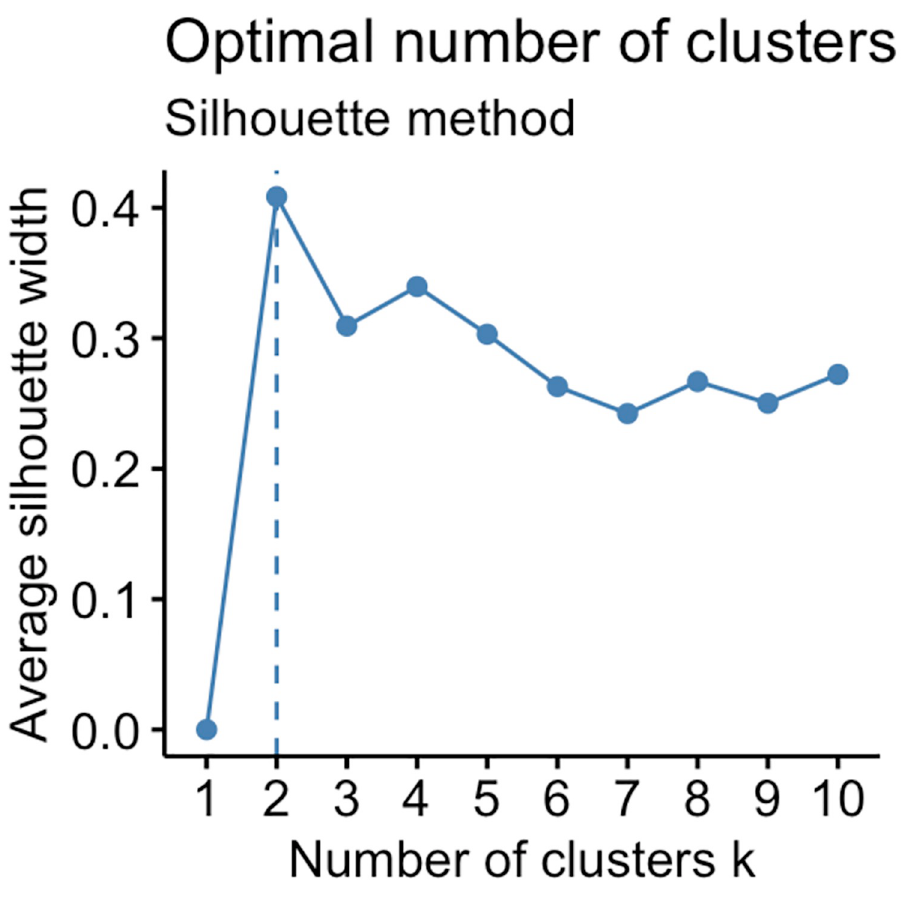
Fig 1. Optimal number of clusters from silhouette